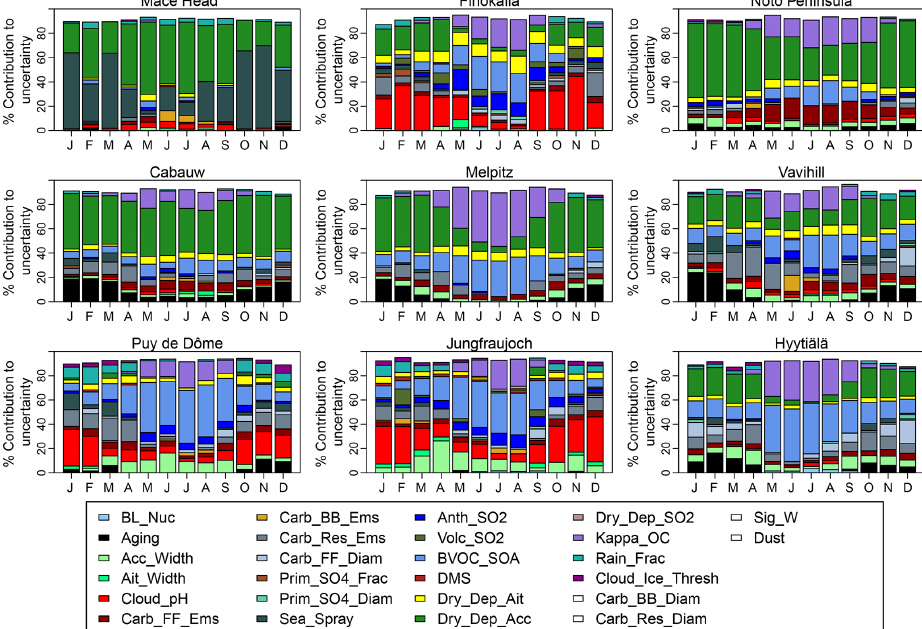
Figure 11. Contribution to the uncertainty in monthly average CCN 0 . 2 based on HadGEM3-UKCA perturbed parameter ensemble simu- lations for the year 2008. Each color refers to 1 of the 26 perturbed parameters as indicated in the legend of the figure. The uncertainty is shown as the percentage contribution of the parameter to the CCN 0 . 2 variance. The assumed parameter uncertainty ranges are given in Yoshioka et al. (2019). All contributions smaller than 1% are not shown. Abbreviations are as follows. BL_Nuc: boundary layer